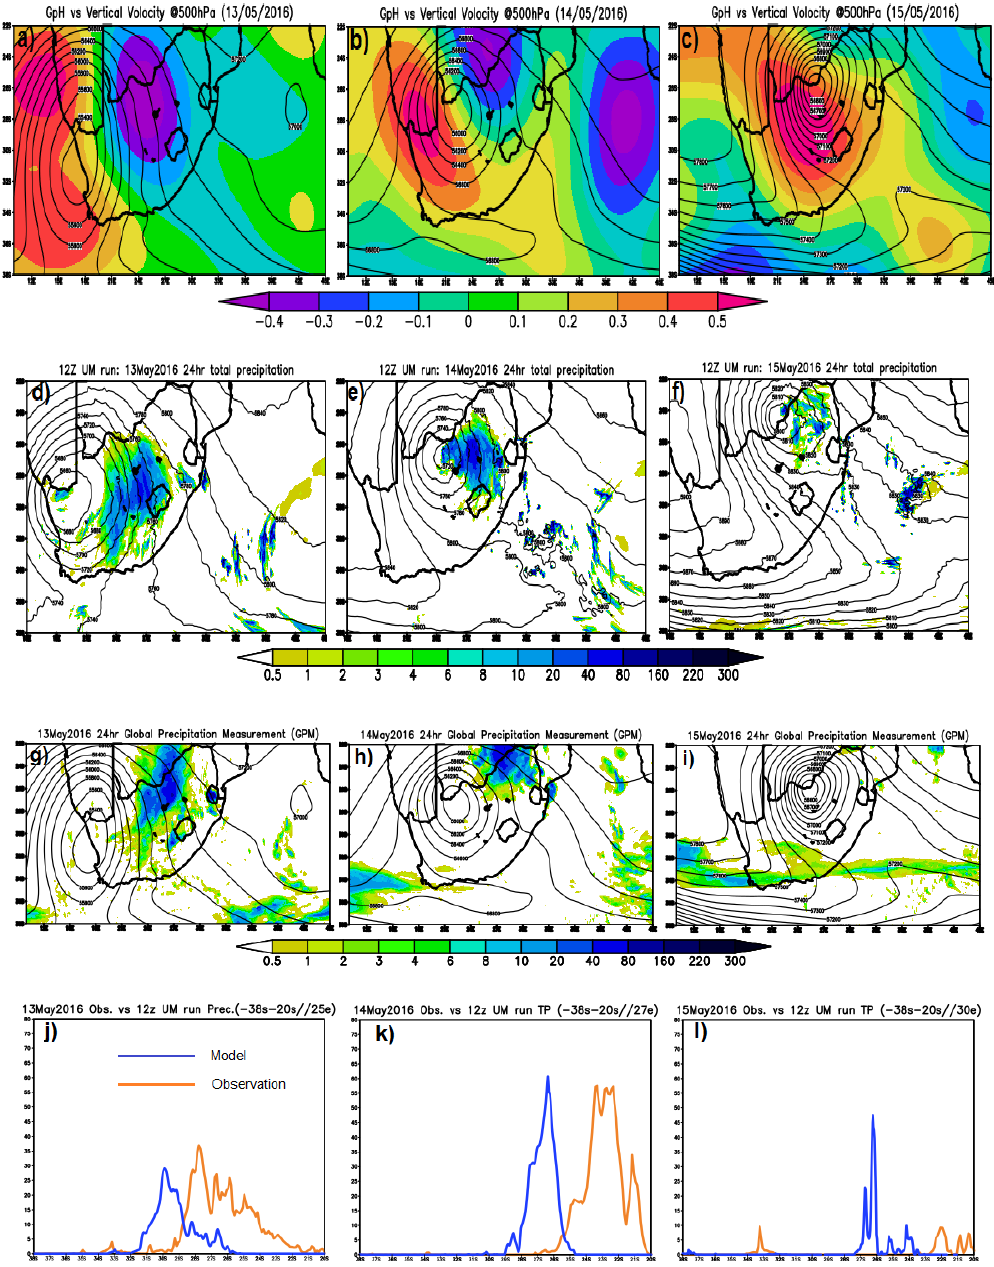
Figure 2. Geopotential height at 500 hPa (thin black contours) together vertical velocity (shaded) ( a , b , c ), at 12Z UM 24 h on the 13th, 14th and 15th May 2016. The second-row panels ( d , e , f ) show total precipitation (shaded) and geopotential height at 500 hPa, at the same as time as in the top panels. The third-row panels ( g , h , i ) show the total precipitation and geopotential height at 500 hPa for the ERA Interim for the same time as in ( a , b , c ). The bottom panels ( j,k,l ) show model (blue curve) and observation (orange curve) diurnal cycle precipitation for the same times as in ( a , b , c ).